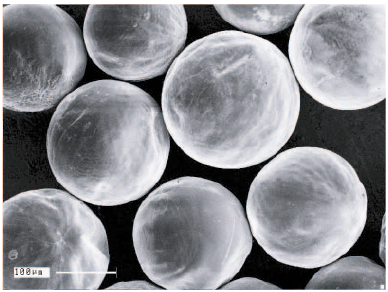
Figure1: Initial cooper powder. Figure 2: Scheme of explosive compaction: 1 – detonator, 2 – explosive charge, 3 – steel plugs, 4 – container (steel tube 12 mm in diameter), 5 – copper powder, 6 – momentum trap.